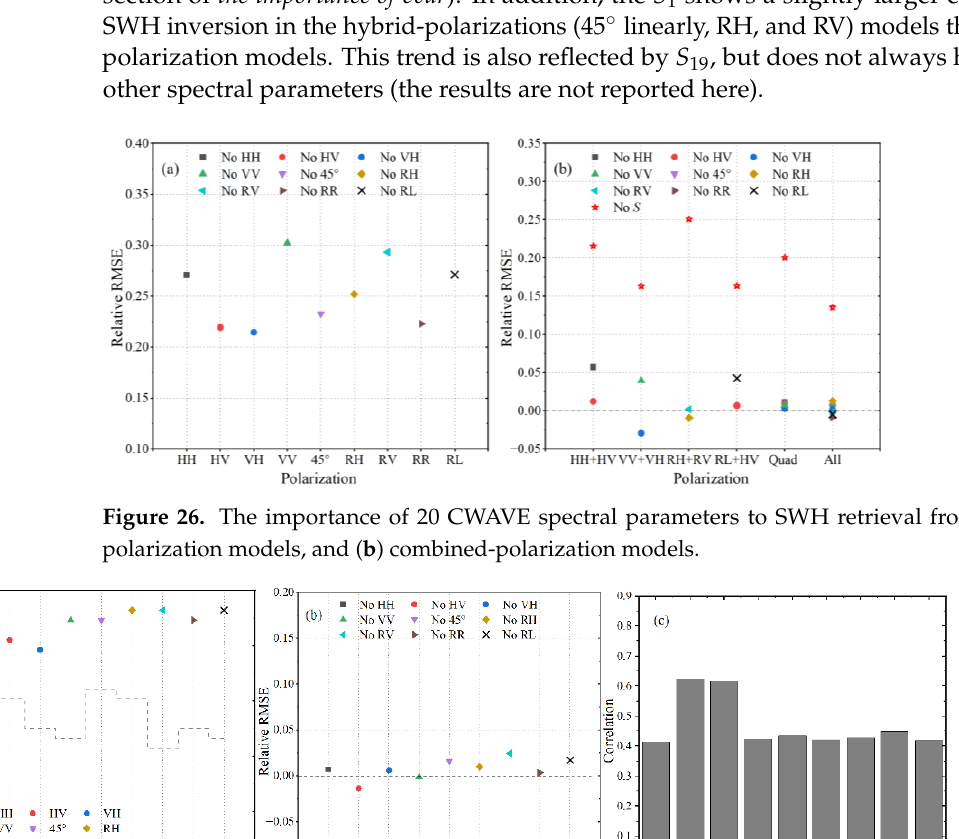
Figure 26. The importance of 20 CWAVE spectral parameters to SWH retrieval from ( a ) single-po- larization models, and ( b ) combined-polarization models.